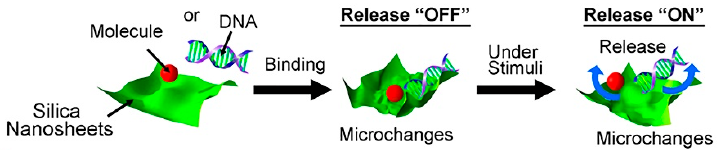
Figure 7. Graphic illustration of the encapsulation and stimuli-responsive release of biomolecules by silica nanosheets. Adapted with permission from [32]. Copyright (2017) American Chemical Society.